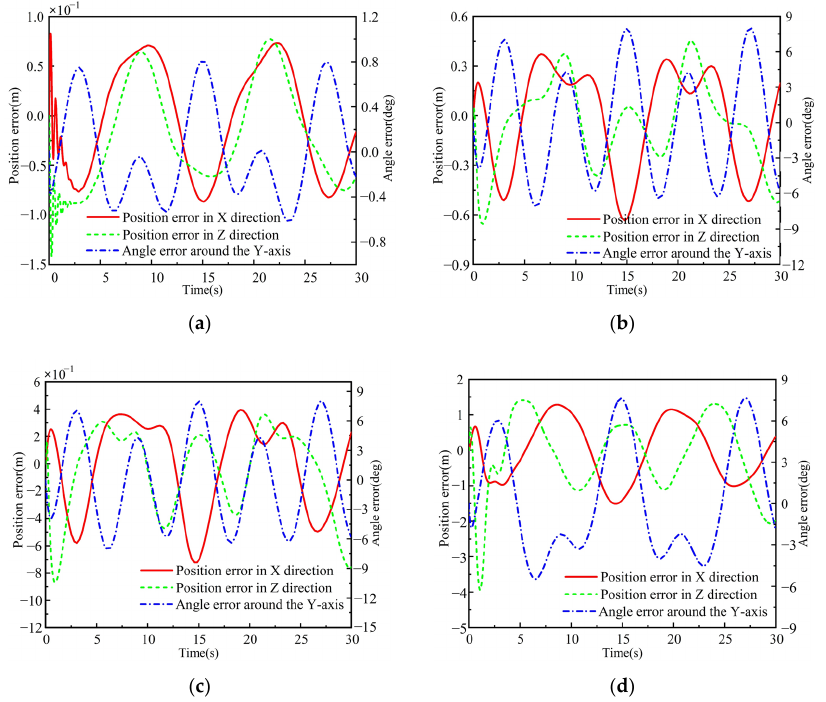
Figure 8. Position tracking error at different speeds: ( a ) Low ‐ speed motion v = 0.6 m/s; ( b ) Medium speed motion v = 3.1 m/s; ( c ) High ‐ speed motion v = 6.3 m/s; ( d ) Ultra ‐ high ‐ speed motion v = 9.4 m/s.